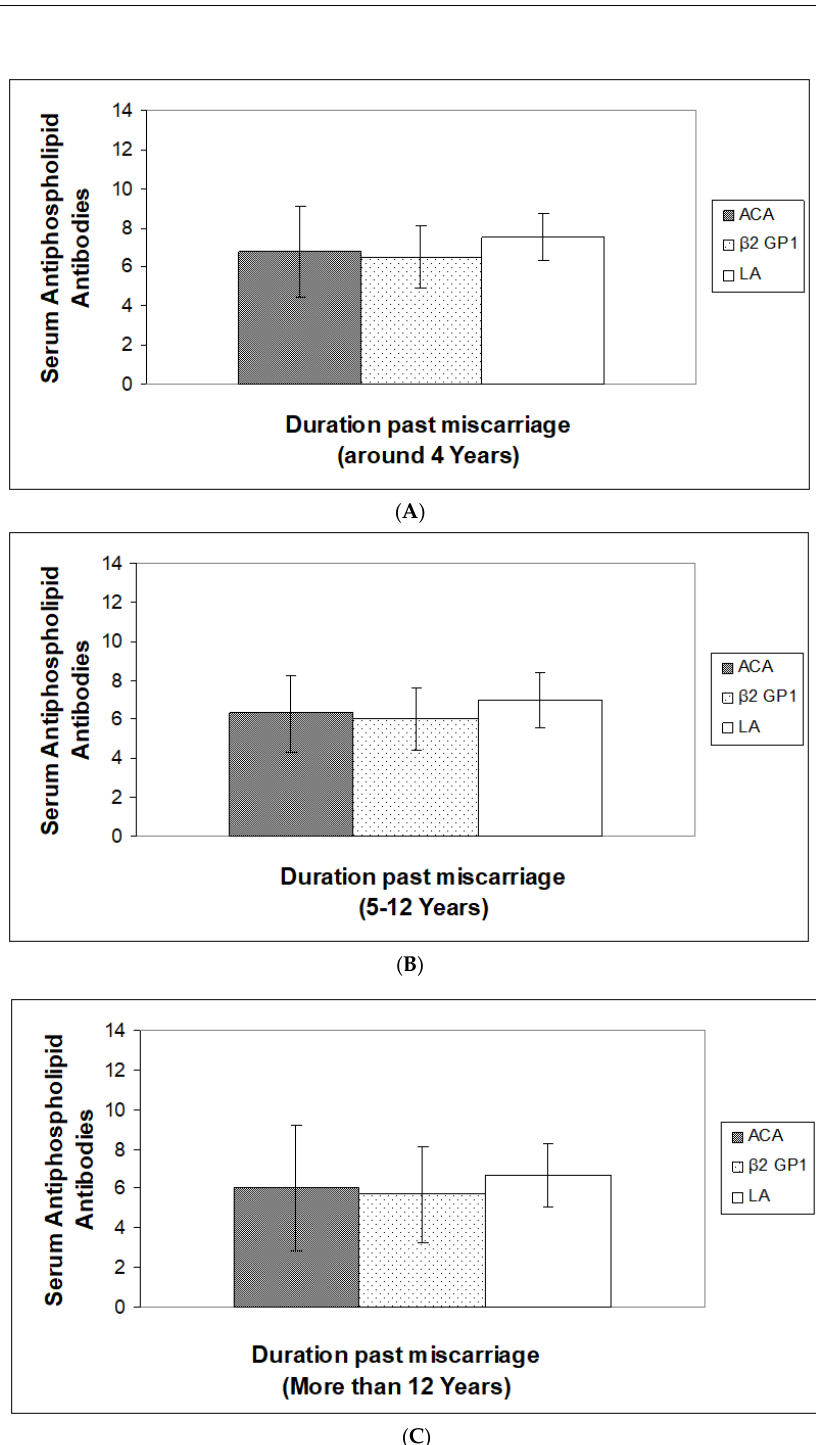
Figure 3. ( A ) Estimation of anticardiolipin (ACA), anti- β2 -glycoprotein- 1 (β2 GP1) and Lupus anticoagulants (LA) based on gestational age of miscarriages (≤ 10 weeks) in Saudi women. Values are Mean ± SD, ( n = 100), n = Total number of subject examinations. ( B ) Estimation of anticardiolipin (ACA), anti- β2 -glycoprotein- 1 (β2 GP1) and Lupus anticoagulants (LA) based on gestational age of miscarriages (11 – 15 weeks) in Saudi women. Values are Mean ± SD, ( n = 100), n = Total number of subject examinations. ( C ) Estimation of anticardiolipin (ACA), anti- β2 -glycoprotein- 1 (β2 GP1) and Lupus anticoagulants (LA) based on gestational age of miscarriages (>15 weeks) in Saudi women. Values are Mean ± SD, ( n = 100), n = Total number of subject examinations.